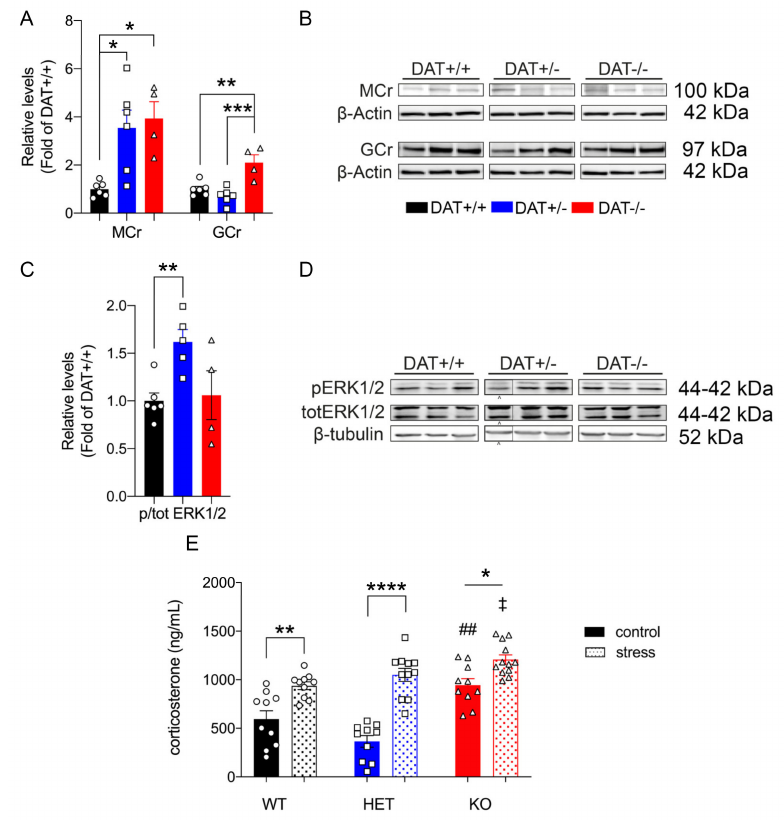
Figure 3. Steroid hormones and ERK1 / 2 changes in the hypophysis of female DAT-KO rats. ( A ) Mineralocorticoid receptor (MCr) levels were increased in both DAT +/ - and DAT- / - female rats, while Glucocorticoid receptor (GCr) levels were increased only in DAT- / - animals. ( C ) DAT +/ - rats showed increase ERK1 / 2 protein levels. ( B , D ) Immunoblots from representative rats in each group are shown (PND60). ( E ) DAT ablation causes alterations of circulating blood levels of corticosterone in basal conditions and after stress. Data were normalized to β -tubulin or β -actin, relative to control (DAT +/+ ). Data were expressed as mean ± SEM ( n = 4–6). * p < 0.05, ** p < 0.01, *** p < 0.001, **** p < 0.0001. ## p < 0.01 DAT- / - vs DAT +/+ and DAT +/ - in basal conditions. ‡ p < 0.05 DAT +/+ stress vs DAT- / - stress. ˆ indicates same-gel / genotype / condition non-contiguous